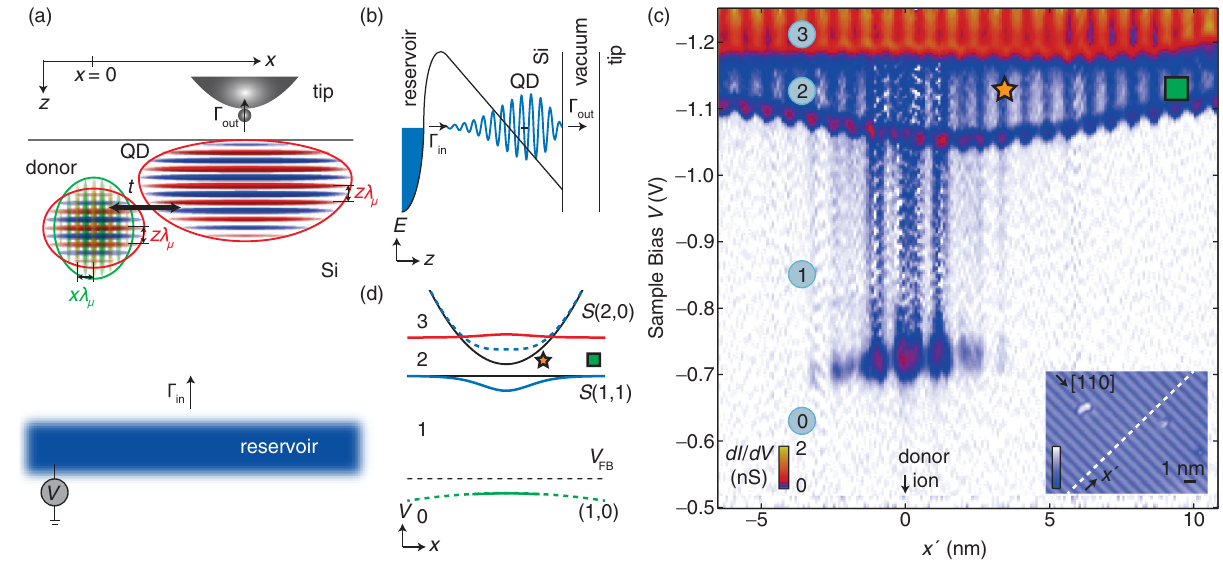
FIG. 1. Schematic of single-electron tunneling from buried reservoir, to coupled donor-QD state, to the tip. The donor wave function parameters are taken from Ref. [58], and the (cid:1) x and (cid:1) z valleys participating in the six-valley superposition are labeled. The (cid:1) y valleys of the donor are omitted for clarity. λ μ ¼ 2 π =k μ , where k μ ¼ 0 . 82 ð 2 π =a 0 Þ is the conduction band minimum wave vector, and a 0 is silicon ’ s lattice constant. (b) Schematic diagram of isolated QD resonance created by tip-induced band bending. (c) Measured dI=dV spectrum labeling the 0,1,2 (donor-QD hybrid) and 3 electron regions along the 110 crystal direction. Inset: Measured topography where dashed line shows locations for dI=dV data. (d) Energy diagram for transitions between 0, 1, 2, and 3 electron states labeled with green, blue, and red lines, respectively. Tunnel coupling t between the donor and QD hybridizes the two-electron states S ð 2 ; 0 Þ and S ð 1 ; 1 Þ , where S ð i; j Þ is the singlet with i electrons on the donor and j on the QD. Unhybridized two-electron states are shown as black lines and hybridized states as blue lines. The star (box) denotes the QD position for strong (weak) hybridization of two-electron states. Temperature is 4.2